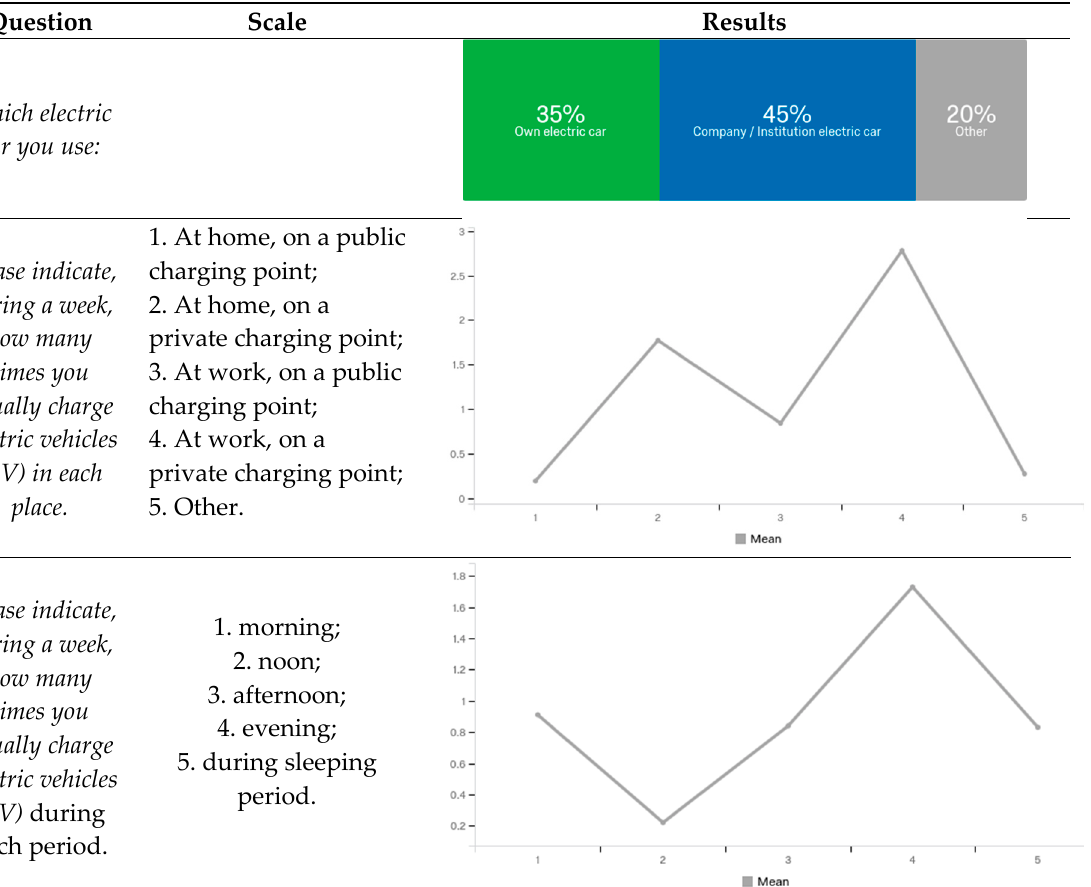
Table A2. Electric car use and